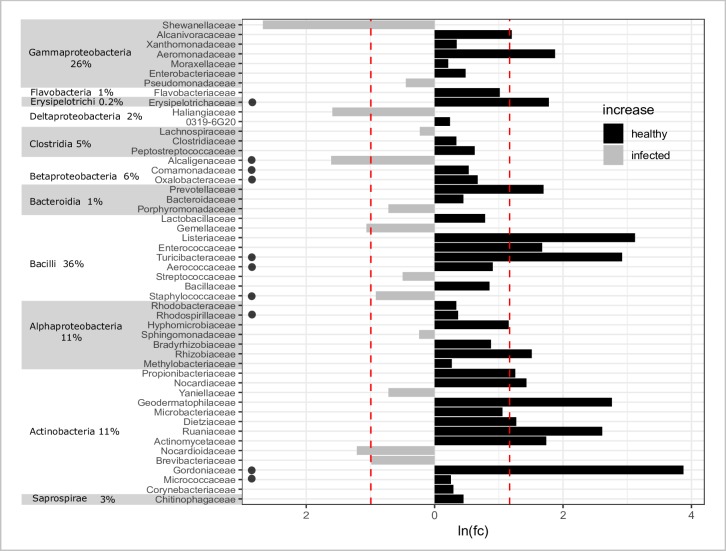
Fifty bacterial families that best differentiate microbiomes of healthy and infected milk.Difference was calculated by subtracting the lesser of the mean abundances from the greater. Families along the y-axis are sorted by class and labeled with the percent of overall milk microbiome sequences that each class represented. Color and direction of bar indicates whether healthy or infected glands was enriched in each taxa. X-axis represents natural log of fold change increase of abundance between infection status; a constant of 1.0 was added to avoid undefined numbers in the case that a family was absent. This occurred in the case of Shewanellaceae (absent in healthy), Gordoniaceae, and Listeriaceae (both absent in infected). Scale is positive in both directions from zero along axis. Red dotted line indicates mean log fold-change increase of presented families. Sequences that could not be classified to family are excluded. Dot to the right of taxon denotes fdr ≤ 0.9 via Kruskal Wallis test.